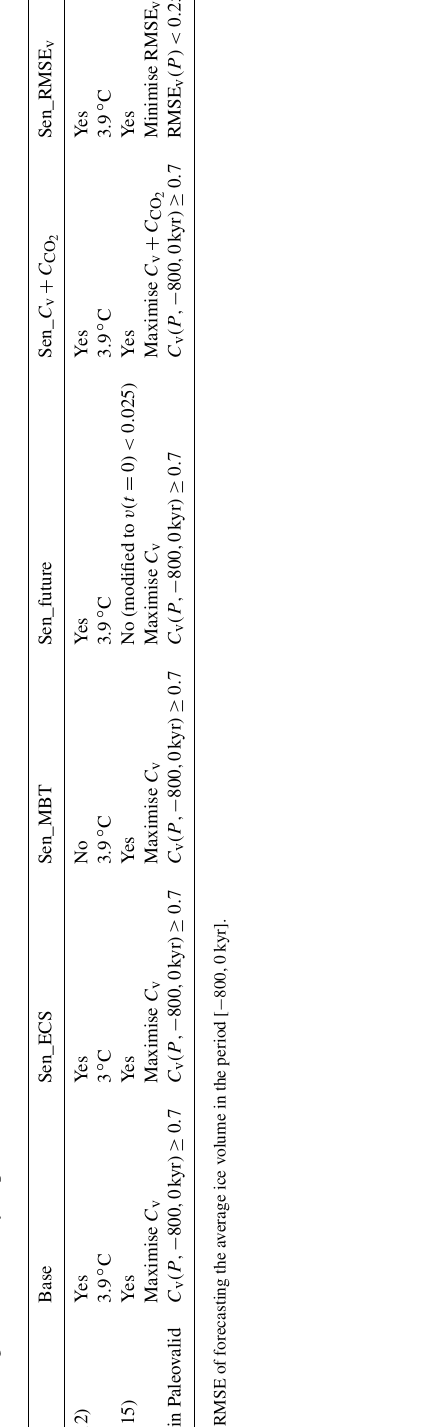
the next glacial